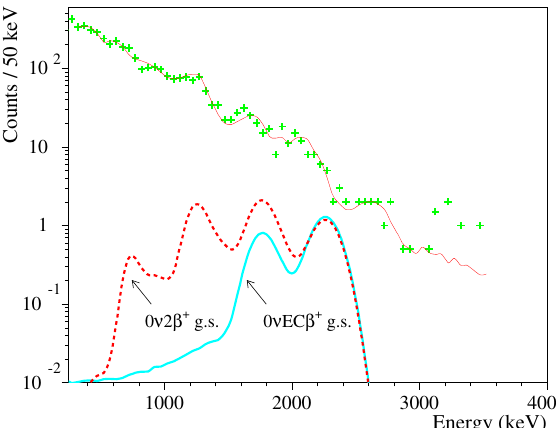
Figure 8. Energy spectrum of the γ and β events measured for 26,033 h by the 106 CdWO 4 detector in coincidence with events in at least one of the CdWO 4 counters with energy E = 511 ± 2 σ keV (crosses). The solid red line shows the fit of the data by the background model (see Section 3.1). Excluded distributions of 0 ν EC β + and 0 ν 2 β + decays of 106 Cd to the ground state of 106 Pd with the half-lives T 1/2 = 1.4 × 10 22 yr and T 1/2 = 5.9 × 10 21 yr, respectively, are shown.